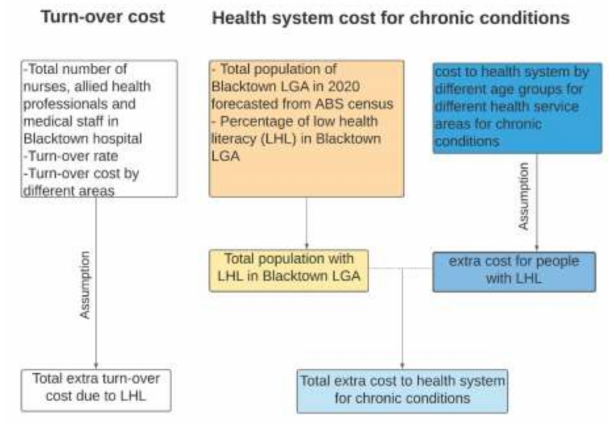
Figure 1. Estimating the economic burden of low health literacy (LHL) on the health care system.